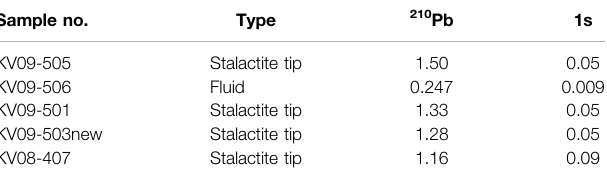
TABLE 4 | 210 Pb data for gypsum — fl uid pairs and the tip laths of stalactites. Sample